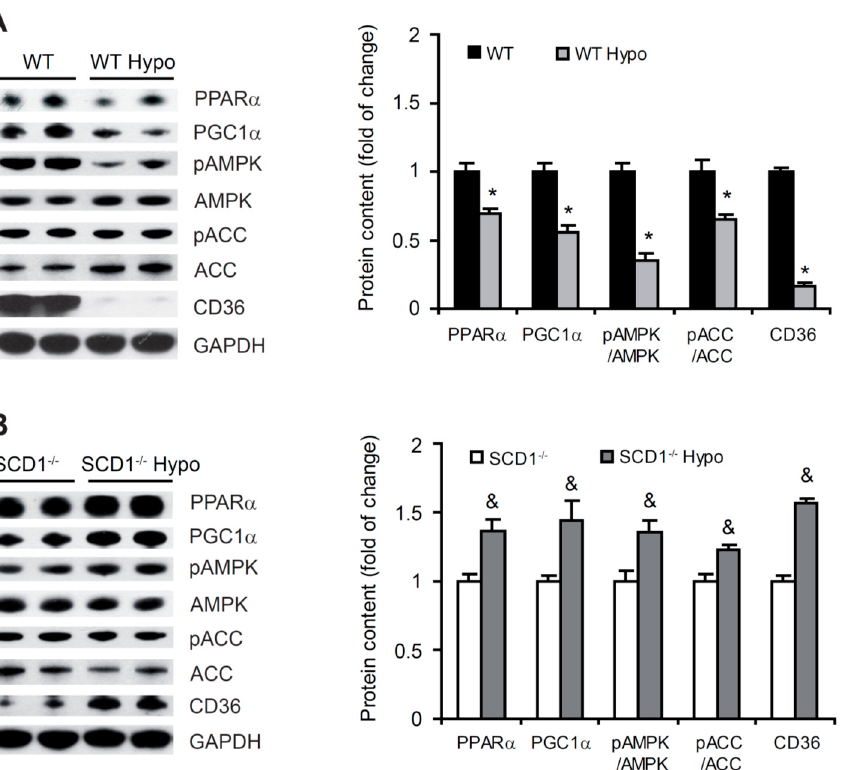
Figure 5. Effect of SCD1 deficiency and hypothyroidism on β -oxidation in the heart. Protein levels of peroxisome proliferator-activated receptor α (PPAR α ), peroxisome proliferator-activated receptor γ coactivator 1 α (PGC1 α ), 5 ′ -adenosine monophosphate-activated protein kinase (AMPK), phosphorylated AMPK (pAMPK), acetyl-CoA carboxylase (ACC), phosphorylated ACC (pACC), and fatty acid translocase (CD36) in the heart were determined in ( A ) wildtype (WT) and ( B ) SCD1 -/- mice by Western blot. The data are representative of n = 5 animals/group. The data are expressed as mean ± SD. * p < 0.05, vs. WT; & p < 0.05, vs. SCD1 -/- .